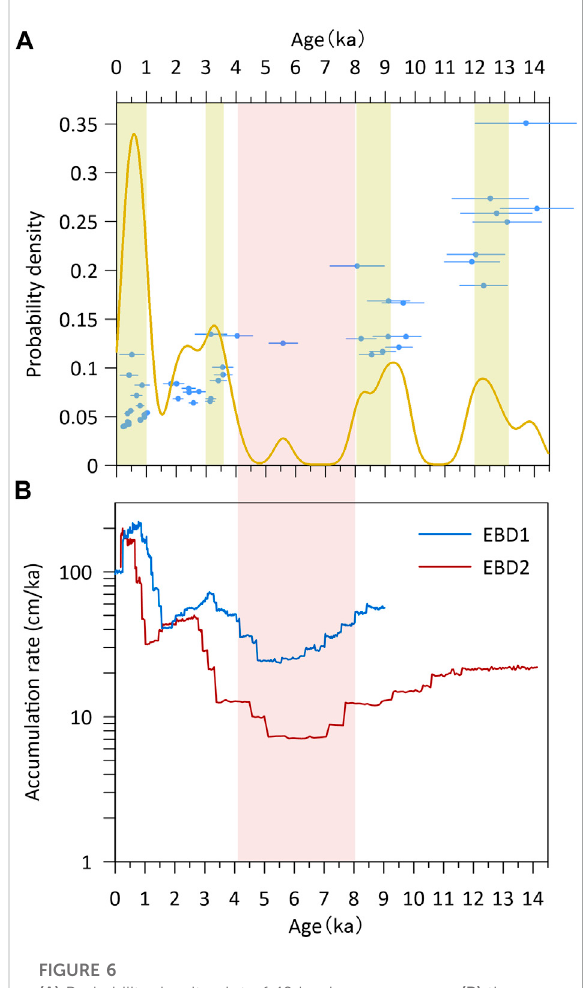
FIGURE 6 (A) Probability density plot of 49 luminescence ages; (B) the calculated accumulation rates of EBD1 (blue line) and EBD2 (red line) sections. The ruby red bar shows the lowest accumulation rate phase while the yellow bars denote the peaks of aeolian